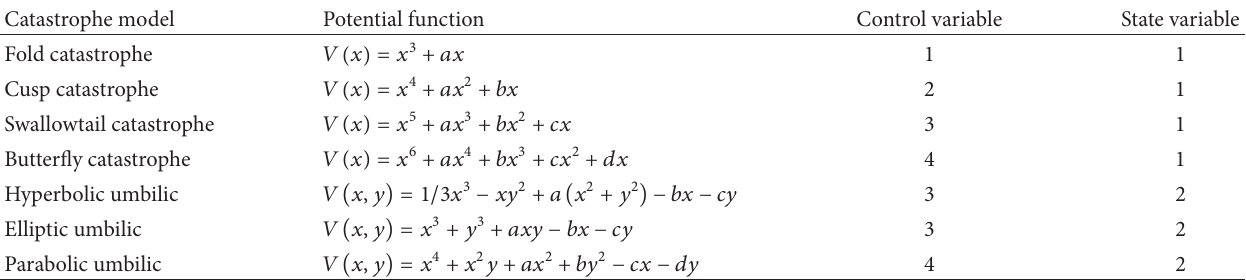
Table 1: Elementary catastrophe